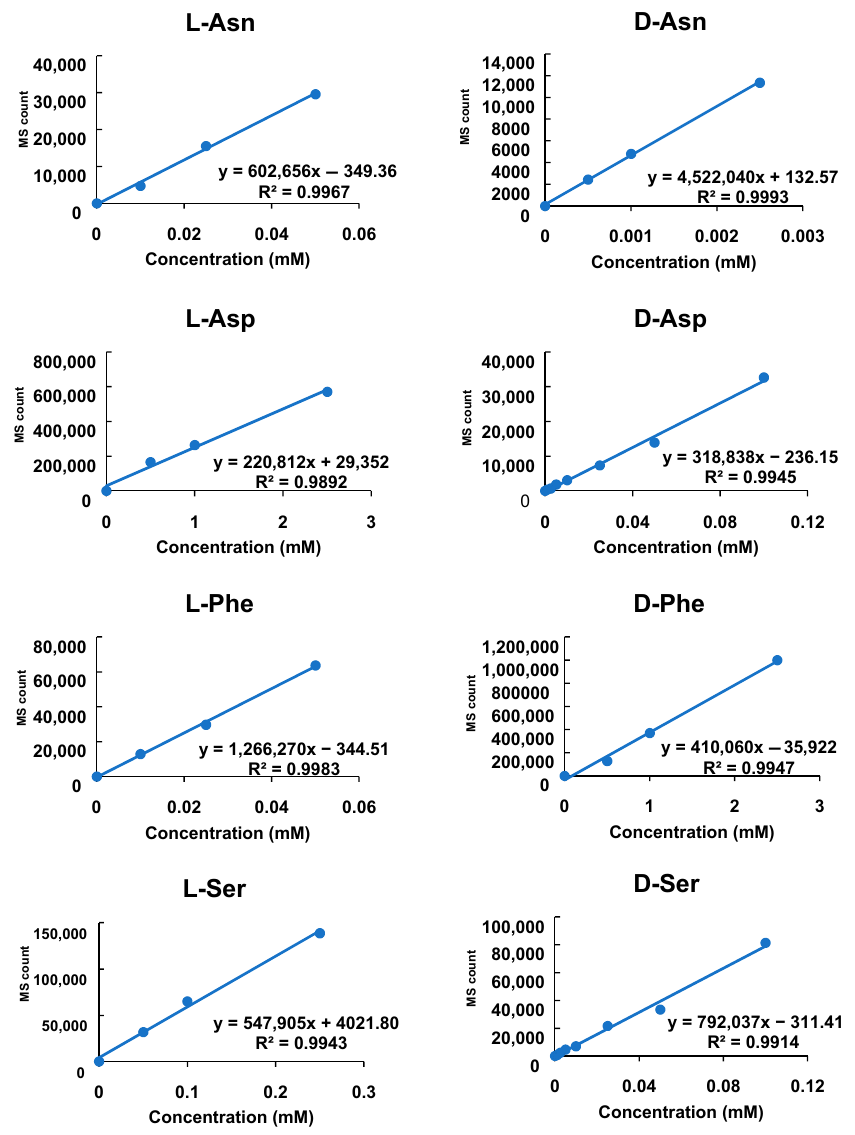
Figure 5. Standard curves of derivatized L - and D -amino acids. Trends of MS count to amino acid concentrations were calculated by measuring the several standard solutions. The X -axis represents concentrations of amino acids before being derivatized, and the Y -axis represents the integrated sum of the peak area from each chromatogram. The equations and R 2 values of each plot are shown.